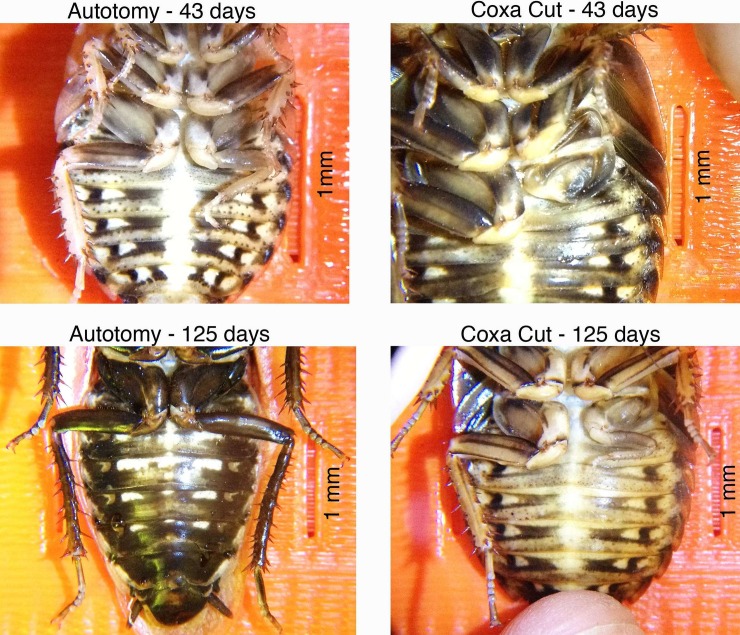
Observation of cockroach legs at various time points.Note that at 43 days a well-formed regenerated leg exists in the autotomy cockroach, but the coxa-cut cockroach only reveals a healed coxa and lacks a regenerated leg. At 125 days, the autotomy-removed leg has fully regrown, but in the coxa-cut leg, the regenerated leg is still quite small. Images over time are not necessarily of the same cockroaches.